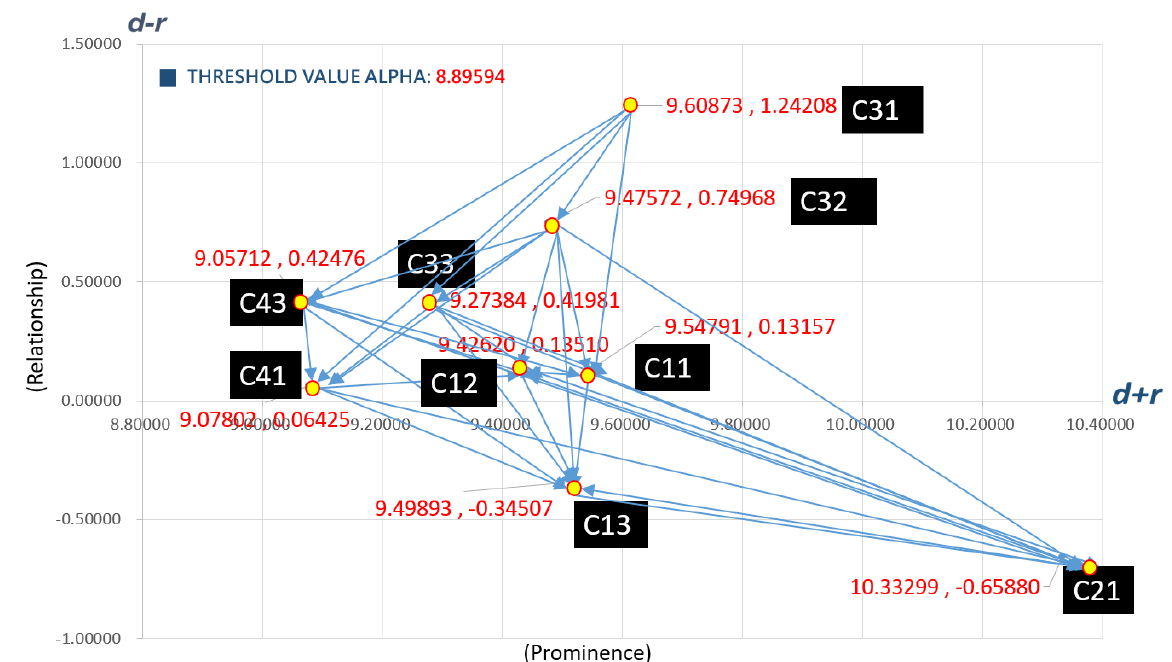
Figure 4. A causal diagram of key factors for supplier selection in the TFT-LCD industry.